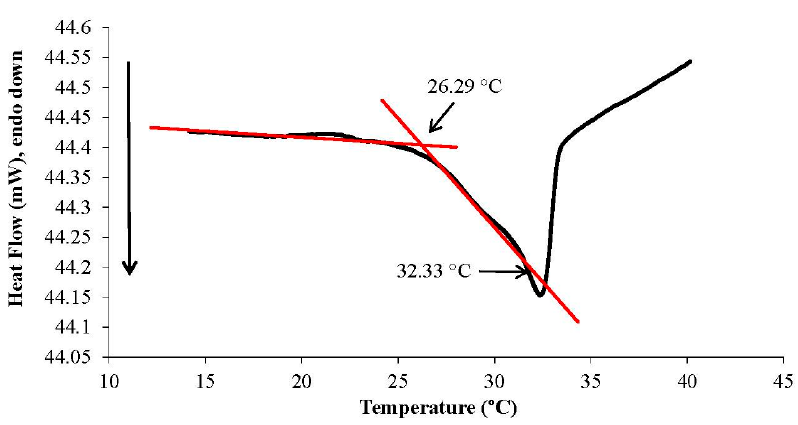
(cid:5) (cid:5) C to 70 C at a heating